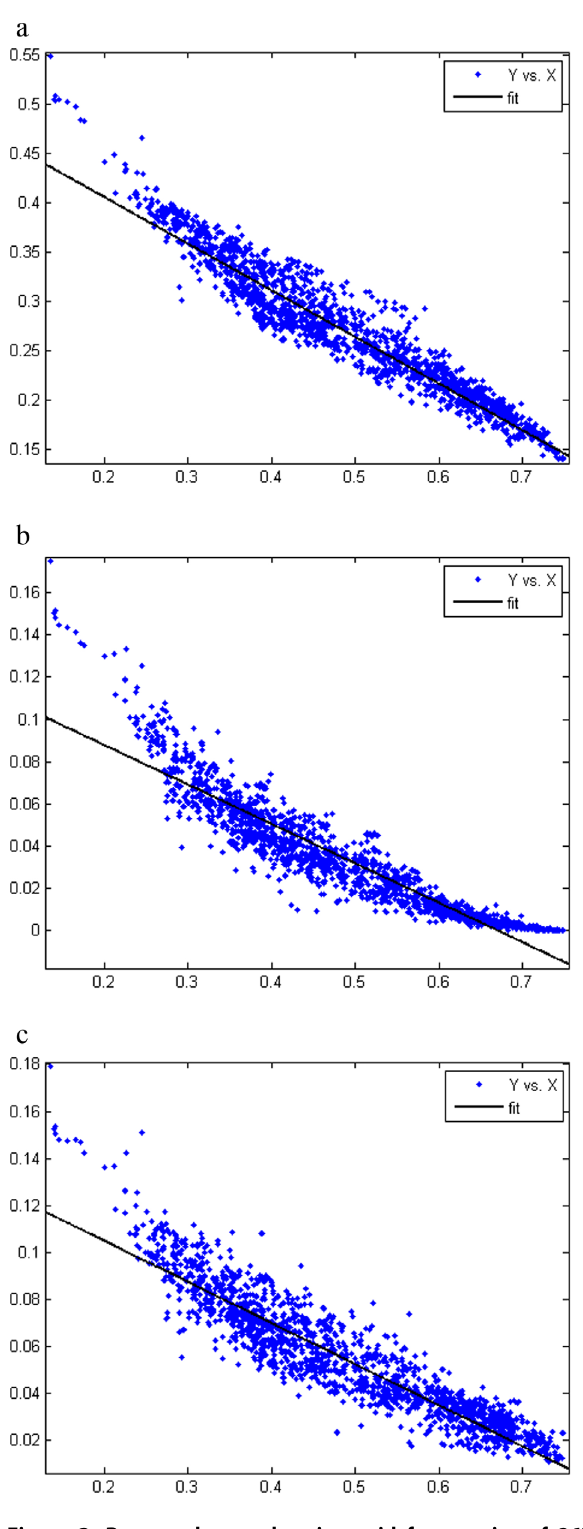
Figure 3. Base, codon, and amino acid frequencies of 2670 prokaryotic genomes plotted against the genomic GC content. a) Y: Base A frequency at the first codon position; X: genomic GC content. b) Y: Codon AAA frequency; X: genomic GC content. c) Y: Amino acid Lys frequency; X: genomic GC content.